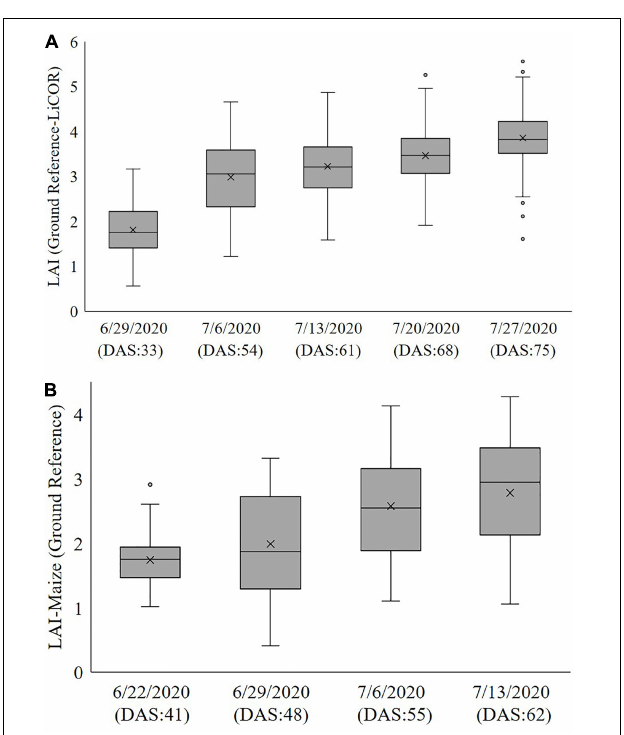
FIGURE 3 | Measured ground reference LAI of (A) SbDivTc_Cal and (B) HIPS using LAI–2200C (2020).